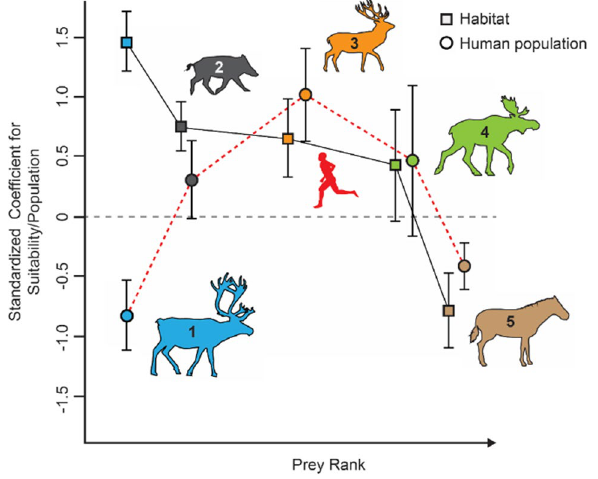
Figure 4. Relationship between top-ranked prey species habitat suitability and LUP human population impacts measured by standardized beta coefficients and standard error estimates for each individual species-specific pSEM. Squares represent the calculated coefficients for species habitat suitability. Theory predicts that as we descend in prey rank beta coefficients decrease while the error increases suggesting that models are performing worse the lower the prey rank, in turn suggesting a positive relationship between predictive strength and prey rank. Circles represent the coefficients for human population. There is a clear parabolic effect but note that the coefficients alone suggest zooarchaeological abundances of reindeer decline as populations expand and zooarchaeological abundances of red deer increase as population increase, although these relationships are non- significant in our models. The remaining values yield standard errors overlapping with